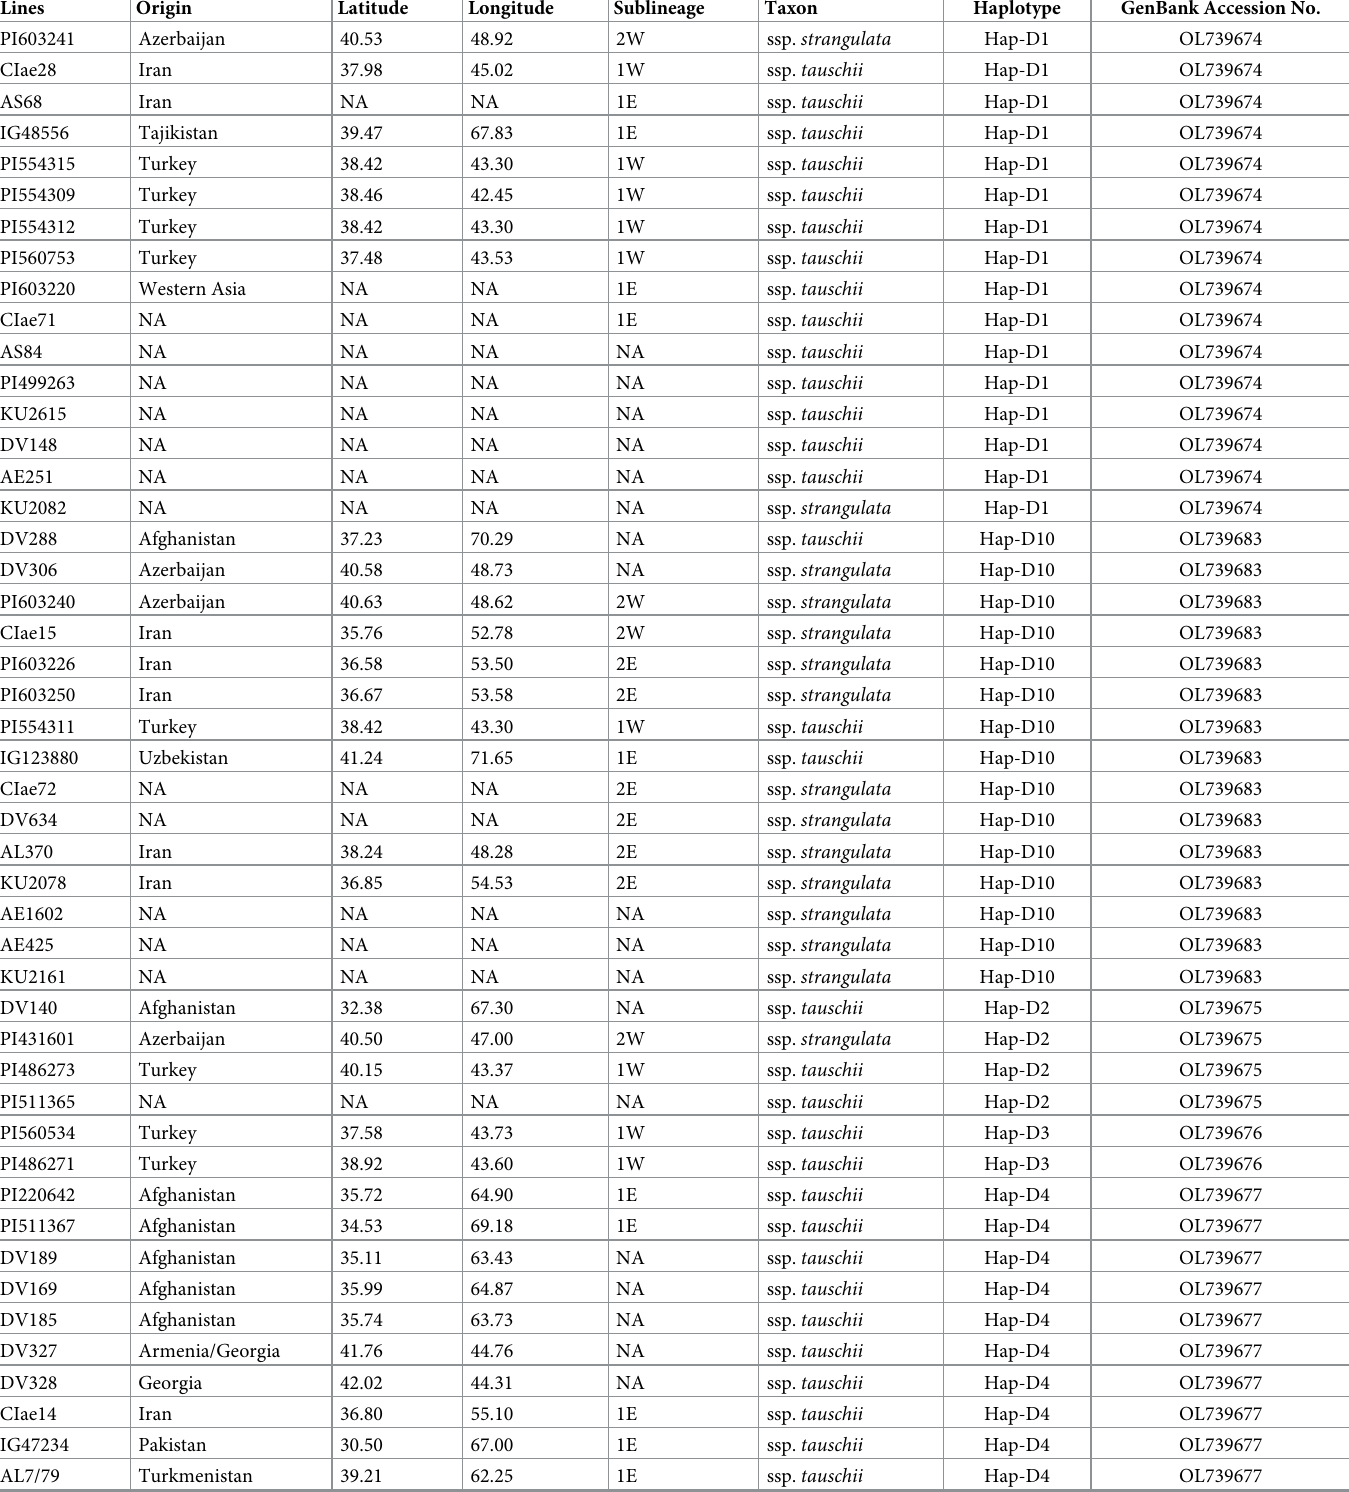
Table 1. Information on Ae . tauschii samples used in this study.